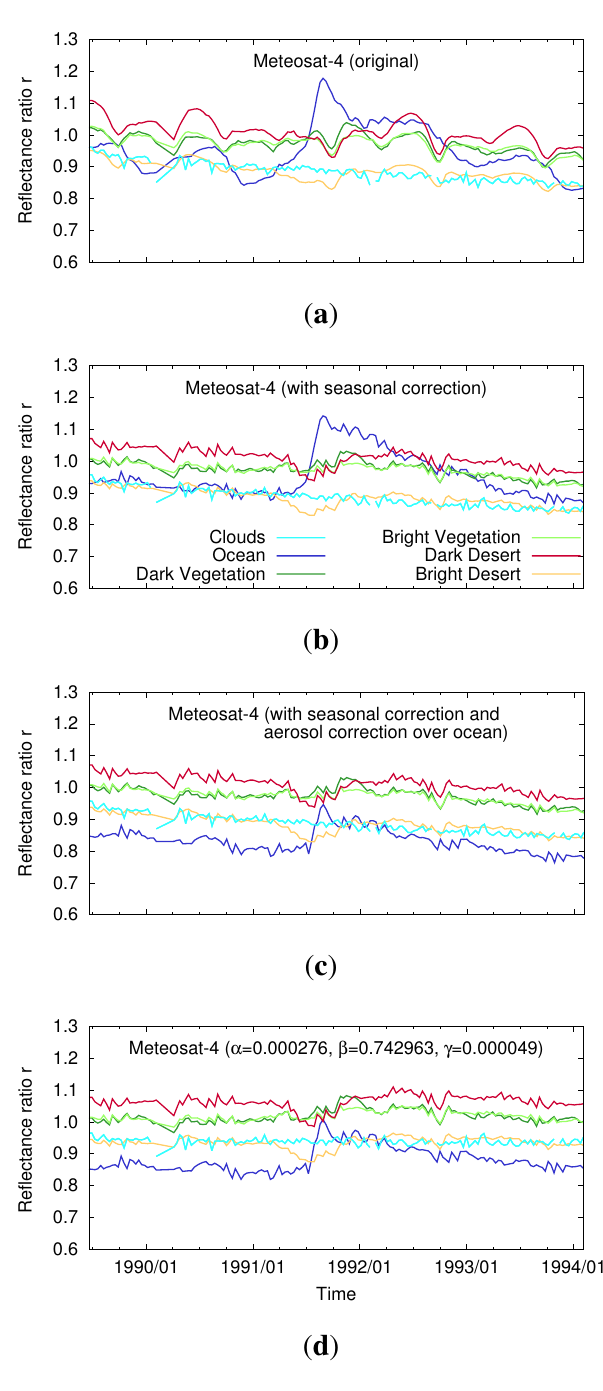
Figure 11. Meteosat-4 time series ( a ) original; ( b ) after seasonal correction; ( c ) after aerosol correction; and ( d ) after ageing